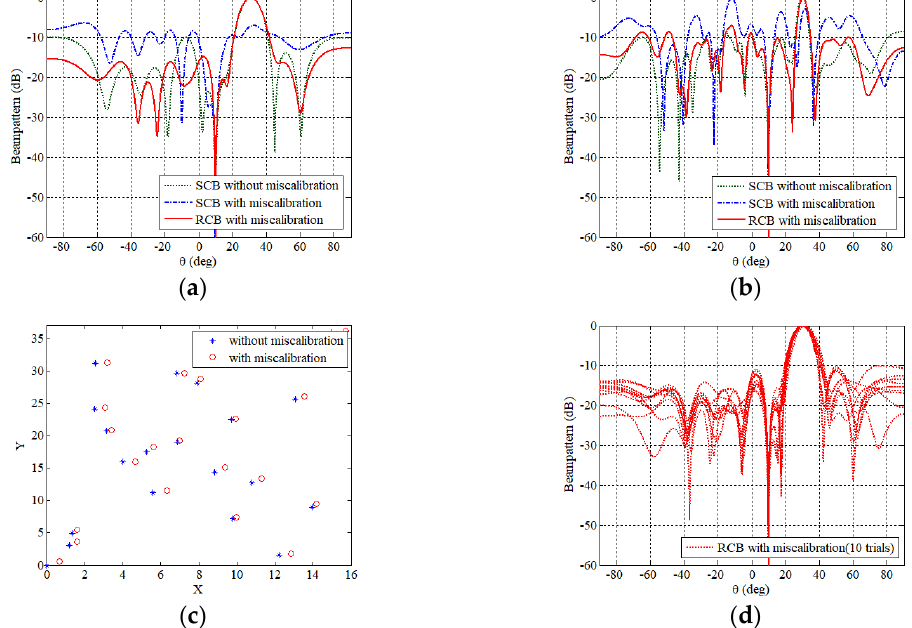
Figure 3. Comparison of the beampatterns in the ( a ) 𝜑 = 0° and ( b ) 𝜑 = 60° plane of the SCB without mis-calibration, the SCB and the RCB with mis-calibration. ( c ) The elements’ locations with and without mis-calibration. ( d ) The beampatterns of RCB with mis-calibration through 10 trials.